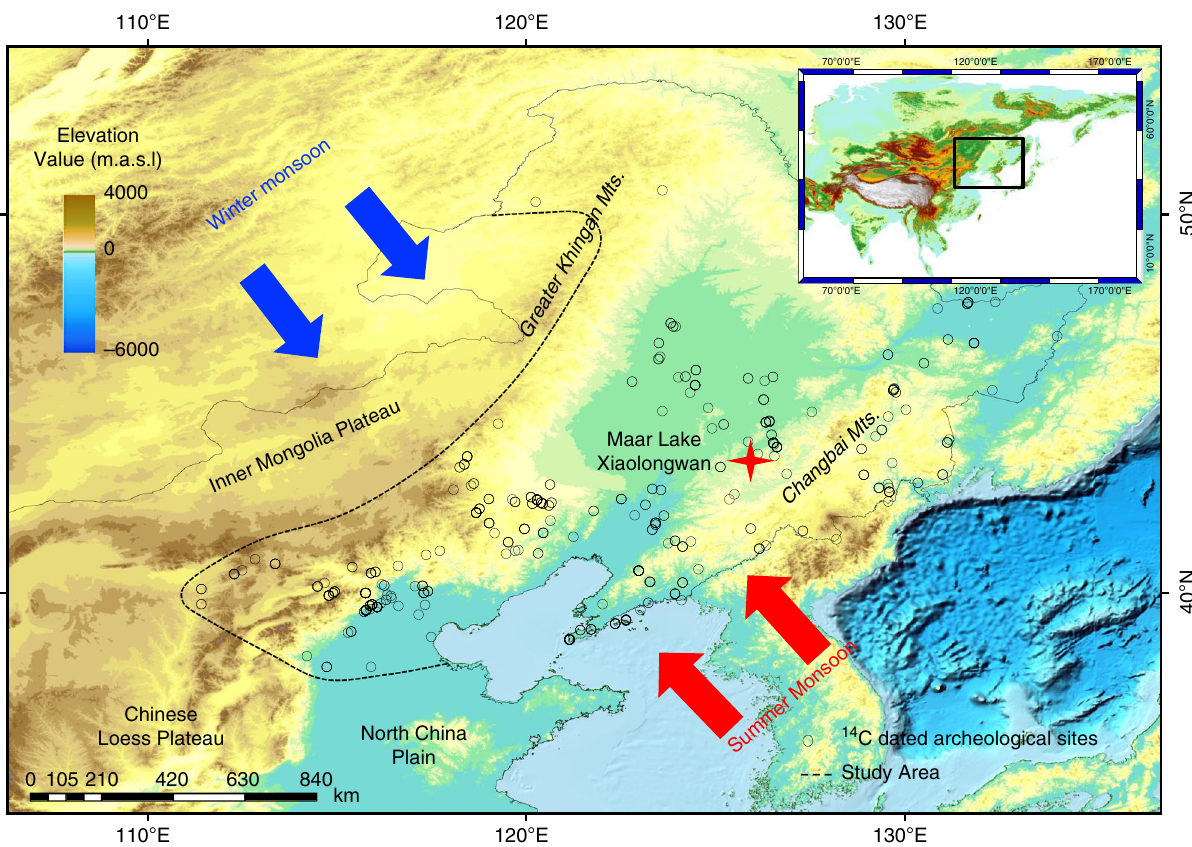
Fig. 1 Locations of Maar Lake Xiaolongwan (red star) and radiocarbon dates from Neolithic archeological sites in NE China (open circles). Trajectories of the East Asian Summer Monsoon and Winter Monsoon are shown by red and blue arrows, respectively. This fi gure was generated using DIVA-GIS 7.5